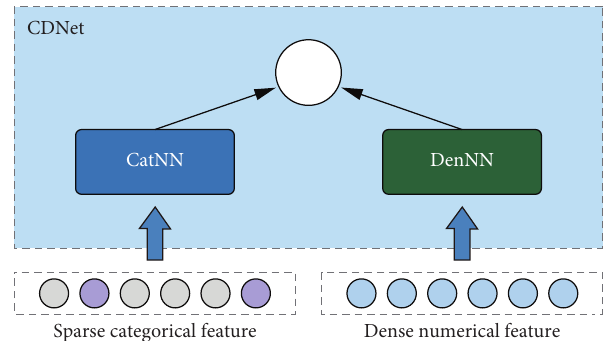
Figure 1: Diagram of the CDNet neural network architecture.